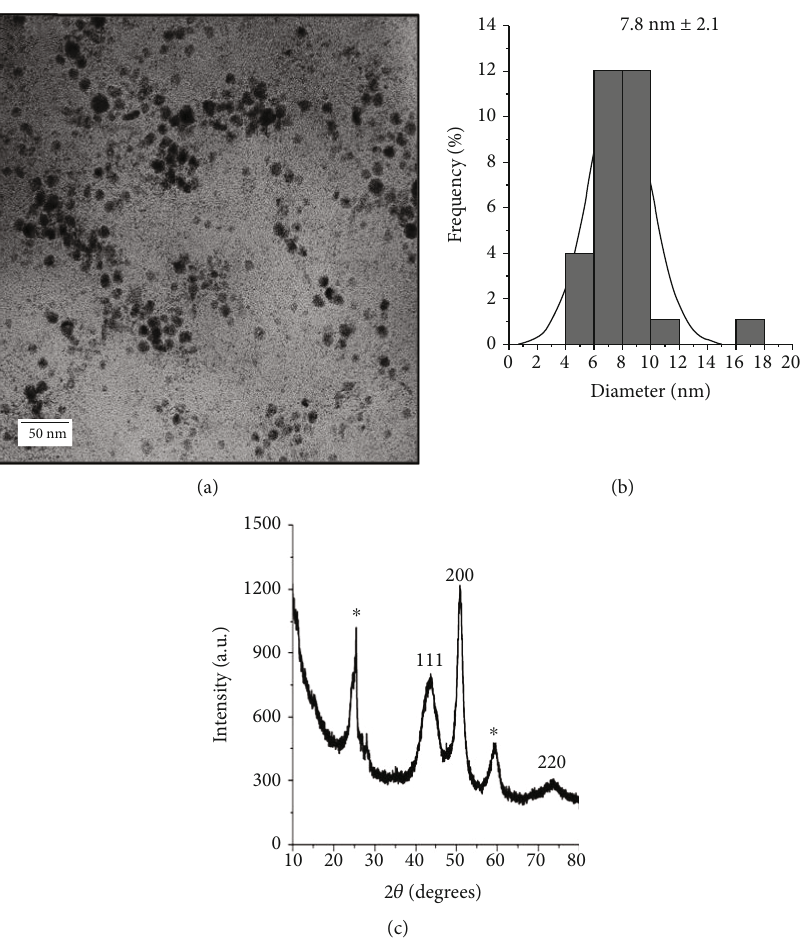
Figure 3: TEM image (a), size distribution (b), and XRD patterns (c) of Cu